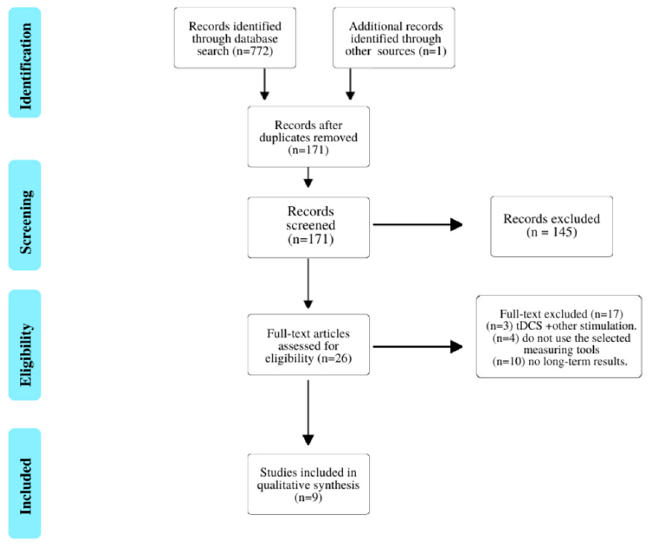
Figure 1. Flowchart of the selection process.